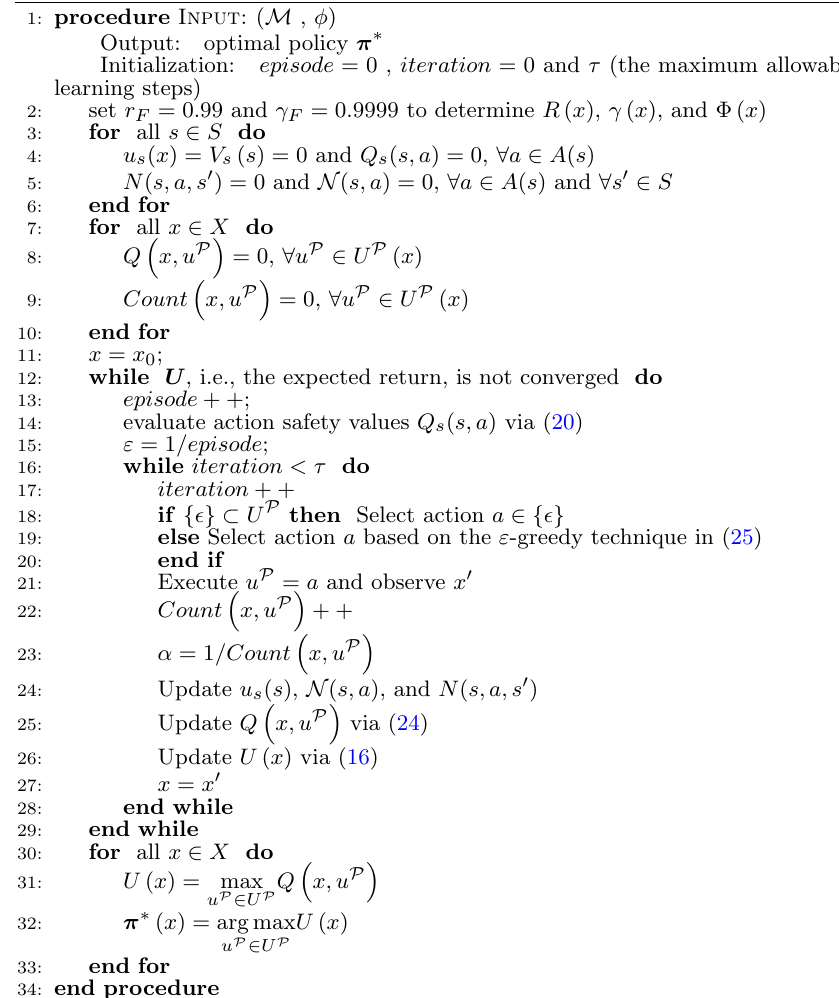
Algorithm 1 Safe reinforcement